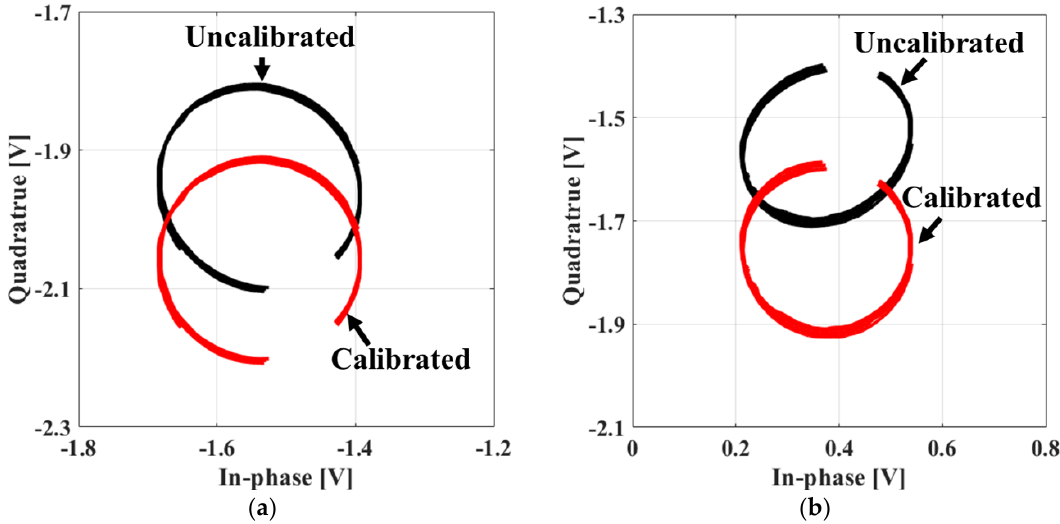
Figure 4. In-phase / quadrature (I / Q) imbalance calibration on the complex plane using the reference distance and the known periodic movement: ( a ) At the frequency of 2.45 GHz; ( b ) at the frequency of 2.5 GHz.